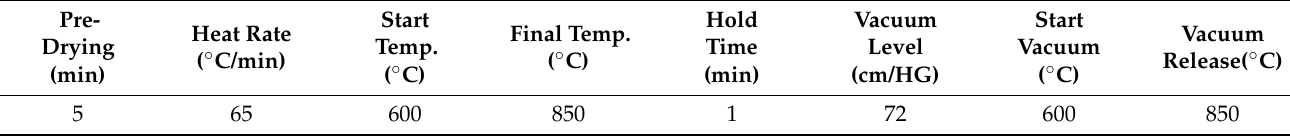
Table 1. Glazing schedule.